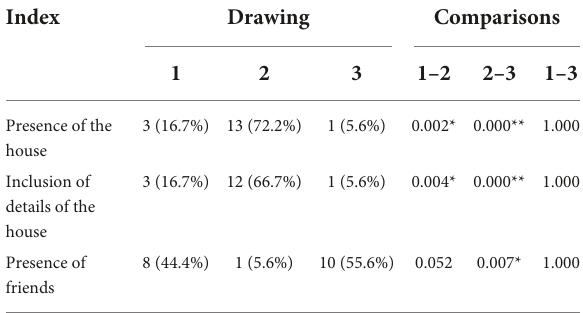
TABLE 5 Significant differences in the distribution of variables within the three